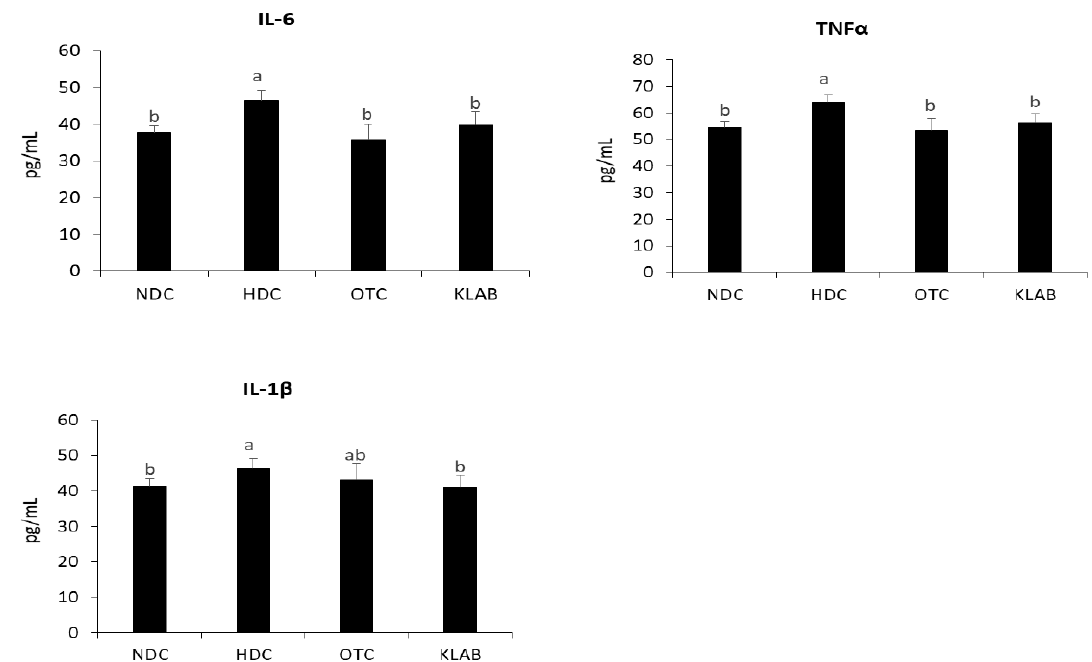
Figure 8. Serum levels of cytokines IL-6, IL-1 β , and TNF α . a-b-c; Values with di ff erent superscripts are significantly di ff erent by ANOVA with Duncan’s multiple range test at p < 0.05. NDC: Normal diet control; HDC: High fat diet control; OTC: high-fat diet plus L-onithine 20 mg / kg; KLAB: High fat diet plus 1 × 10 9 CFU of L. brevis OPK-3 per mouse. TNF α : Tumor necrosis factor-alpha; IL-6: Interleukin 6; IL-1 β : Interleukin 1 beta.